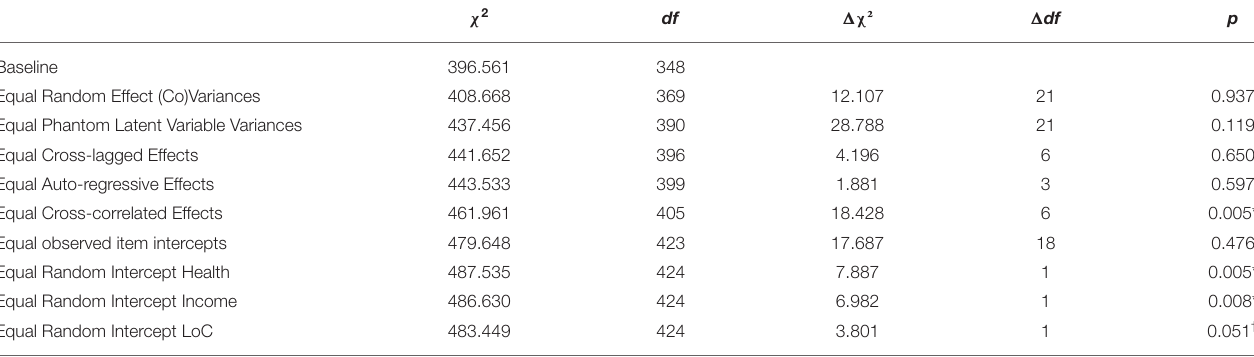
TABLE 4 | Nested model comparisons.